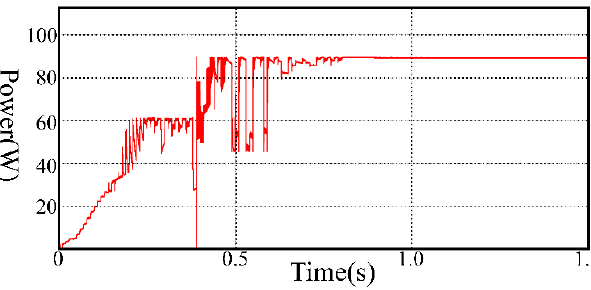
Figure 10. GMPP tracking under PSC with proposed method-Transient response.